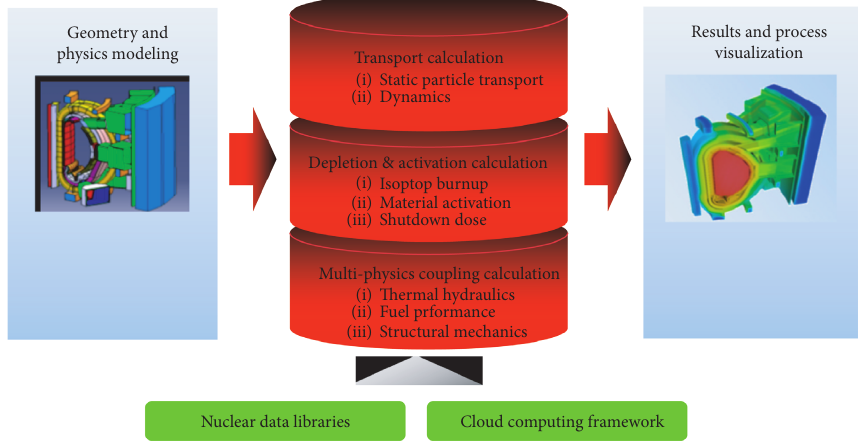
Figure 1: Schematic architecture of the SuperMC radiation transport code. Table 1: Types of fuel assemblies in the PARR-1